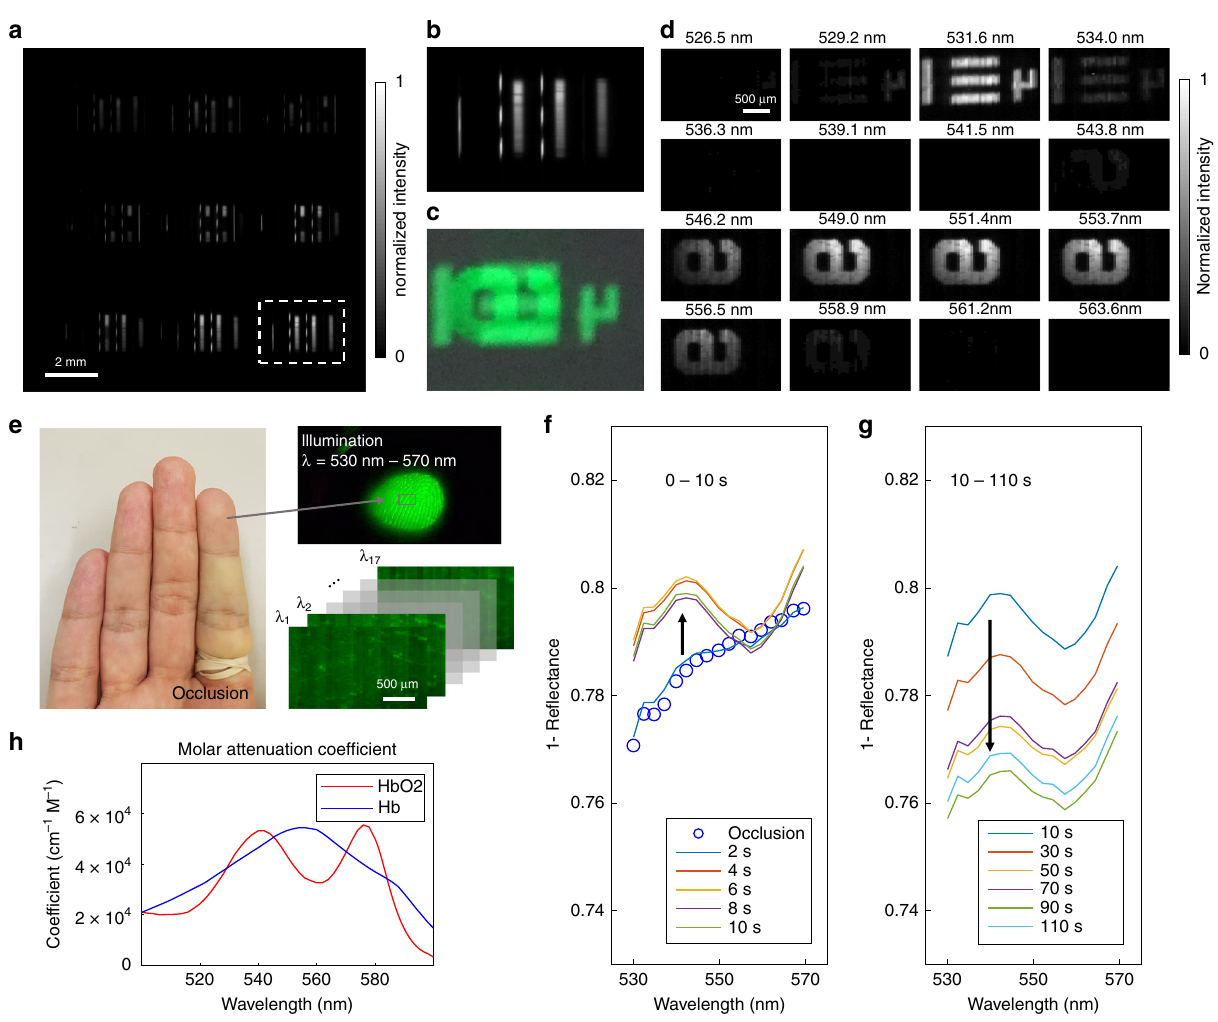
Fig. 3 ( x , y , λ ) imaging through direct optical mapping. a Grey-scale raw image captured by using multidimensional photography. b Magni fi ed view of the image in ( a ). c Image captured by a commercial colour camera. d Hyperspectral images at each spectral channel. Two overlapped USAF target images are distinguished. e An artery in the fore fi nger was occluded with a rubber band. The tip of the fi nger was illuminated by a green light (CWL = 550 nm/FWHM = 40 nm). Spectral re fl ectance of the fi nger was captured after the removal of the rubber band. Short-term ( f ) and long-term ( g ) changes of the spectral response of the fi nger tissue. h Molar attenuation coef fi cient of oxy- and deoxy-haemoglobin 33